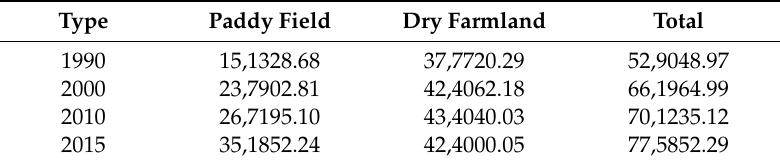
Table 8. Water consumption of cultivated land in di ff erent period (Unit: m 3 / km 2 ). Type Paddy Field Dry Farmland